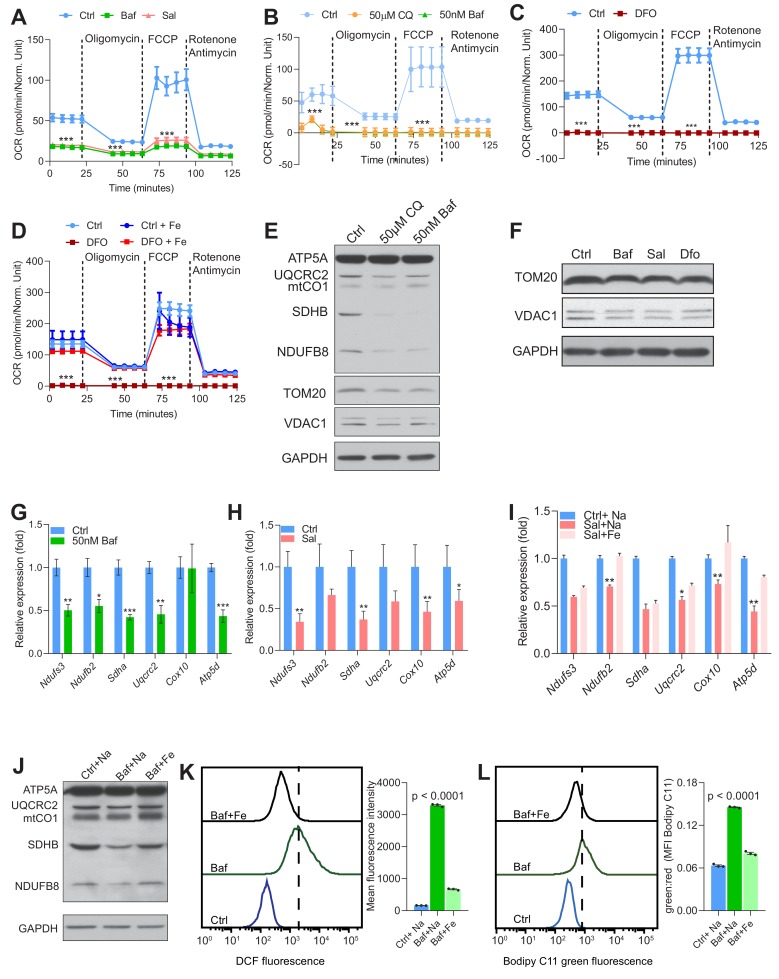
Lysosomal iron efflux is essential for mitochondrial biogenesis and function.(A–C) Mitochondrial OCR in 500 nM Baf- and 500 nM Sal-treated fibroblasts (A), in fibroblasts treated with either vehicle, 50 µM Chloroquine or 50 nM Baf (B) and in 300 µM Dfo-treated fibroblasts (C). Note the seemingly lack of mitochondrial respiration in Dfo-treated fibroblasts. Results represent mean ± SEM, n = 3. Each experimental replicate is calculated from the average of 12 technical replicates. ***p<0.001, Welch’s one-way ANOVA with Dunnett’s correction for multiple comparisons (A, B) and unpaired two-tailed t-test with Welch’s correction (C). (D) 150 µM iron citrate supplementation rescues the barely detected mitochondrial OCR in 300 µM Dfo-treated fibroblasts. Experimental points represent mean ± SEM, n = 3. Each experimental replicate is calculated from the average of 8 technical replicates. ***p<0.001, Welch’s one-way ANOVA with Dunnett’s correction for multiple comparisons with all experimental groups compared to Dfo-treated cells. (E) Immunoblots of whole cell extracts showing ATP5A, UQCRC2, mtCO1, SDHB, NDUFB8, TOM20 and VDAC1 in fibroblasts treated for 24 hr with either vehicle, 50 µM Chloroquine or 50 nM Baf. GAPDH is used as loading control, n = 4 biological replicates. (F) Immunoblots showing reduced TOM20 and VDAC1 protein levels in fibroblasts treated with 500 nM Baf and 500 nM Sal (n = 6). 300 µM Dfo is used as positive control for iron deficiency and GAPDH is used as loading control. (G) Reduced levels of nuclear-encoded mitochondrial transcripts in fibroblasts treated for 24 hr 50 nM Baf. Results are shown as bar graphs representing mean ± SEM of four independent experimental replicates. *p<0.05; **p<0.01; ***p<0.001, unpaired two-tailed t-test with Welch’s correction. (H) Mitochondrial biogenesis is repressed in 500 nM Sal-treated fibroblasts as assessed by the reduced transcript levels of nuclear-encoded mitochondrial genes following 24 hr of treatment with Sal. Results are shown as bar graphs representing mean ± SEM of six independent experimental replicates. *p<0.05; **p<0.01; ***p<0.001, unpaired two-tailed t-test with Welch’s correction. (I) 150 µM iron citrate supplementation in 500 nM Sal-treated fibroblasts, partially rescues the decreased expression of nuclear-encoded mitochondrial genes in fibroblasts treated with Sal alone. Bars depict mean ± SEM, n = 8. *p<0.05; **p<0.01; Welch’s one-way ANOVA with Dunnett’s correction for multiple comparisons. All conditions are compared to the Sal alone treatment group. (J) Immunoblots of whole cell extracts showing ATP5A, UQCRC2, mtCO1, SDHB and NDUFB8 in 500 nM Baf-treated cells and in 150 µM iron citrate supplemented-Baf treated fibroblasts (n = 3). Note the rescue of the decreased levels of mitochondrial proteins (NDUFB8, SDHB and mtCO1) following iron supplementation in Baf-treated cells. GAPDH is used as loading control. (K–L) 150 µM iron citrate supplementation rescues Baf-induced increase in the levels of reactive of oxygen species (DCF) and in the levels of lipid peroxidation (Bodipy C11). Results are depicted representative histograms of three independent experimental replicates and quantifications are shown as mean ± SEM. p values are determined by the Welch’s one-way ANOVA with Dunnett’s correction for multiple comparisons to Baf-treated fibroblasts.